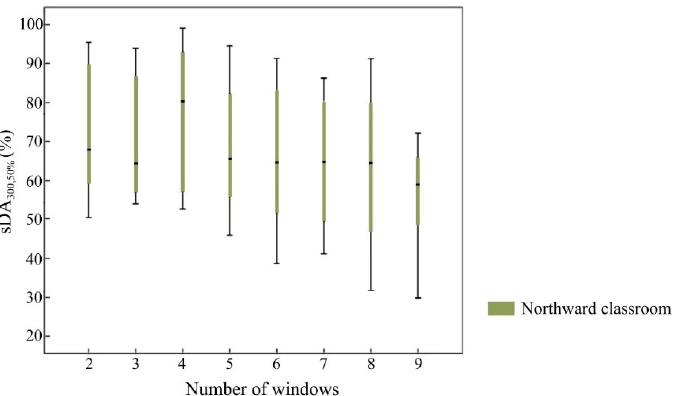
Figure 12. The analysis results of the distribution interval between the number of windows and the evaluation index.